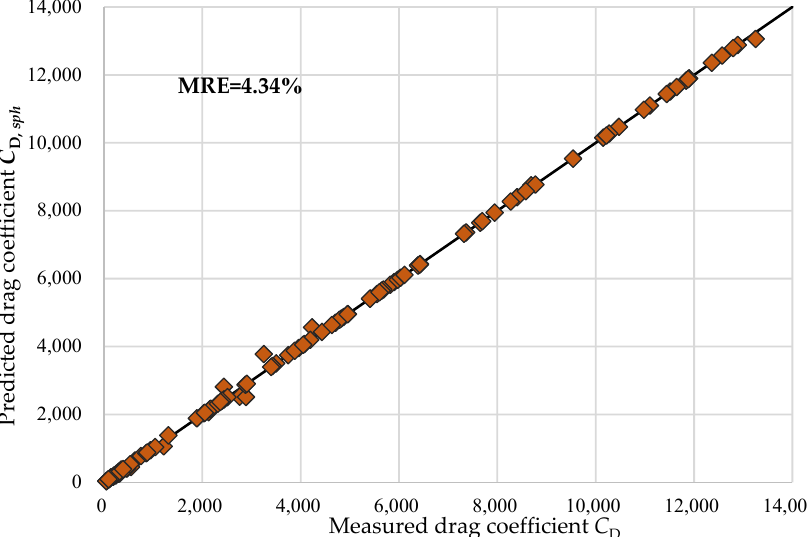
Figure 9. Comparison between the predicted value of this model and the experimentally measured value of the settling drag coefficient of spherical particles.